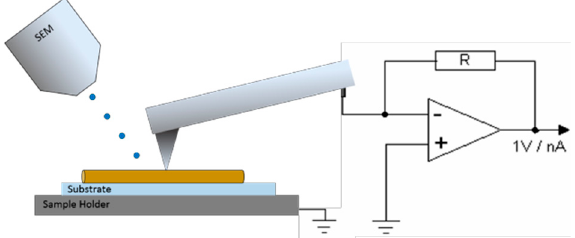
Figure 1. Sketch of the EBIC measurement setup inside the SPM-SEM combination.